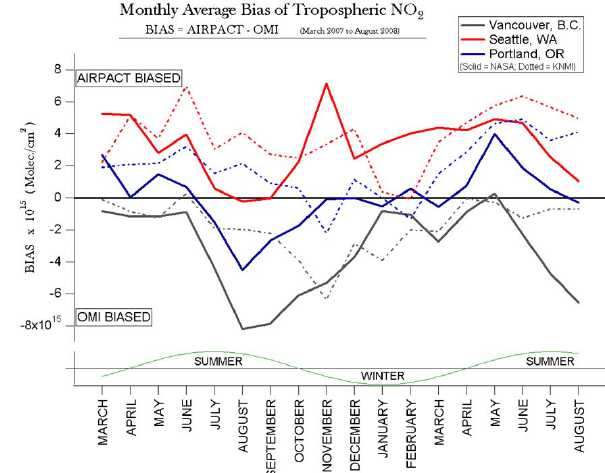
Fig. 10. Monthly Average NO 2 for Seattle, Washington over 18 months. The bars show standard deviation of spatial variation over a 1728km 2 area (12 AIRPACT pixels) while the whiskers show the extent of the maximum and minimum. Values are in molecules per square centimeter.